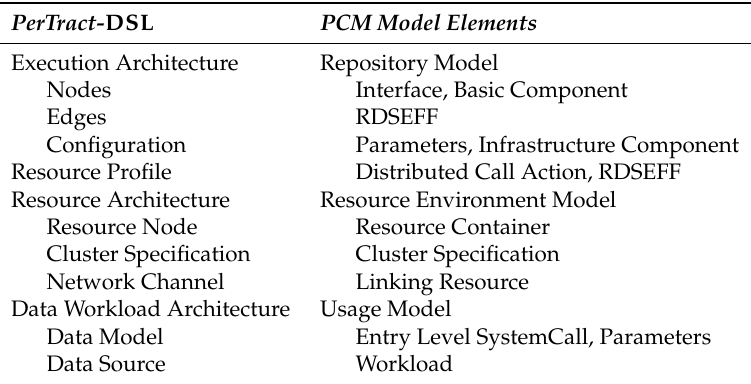
Table 1. Mapping of PerTract-DSL to PCM